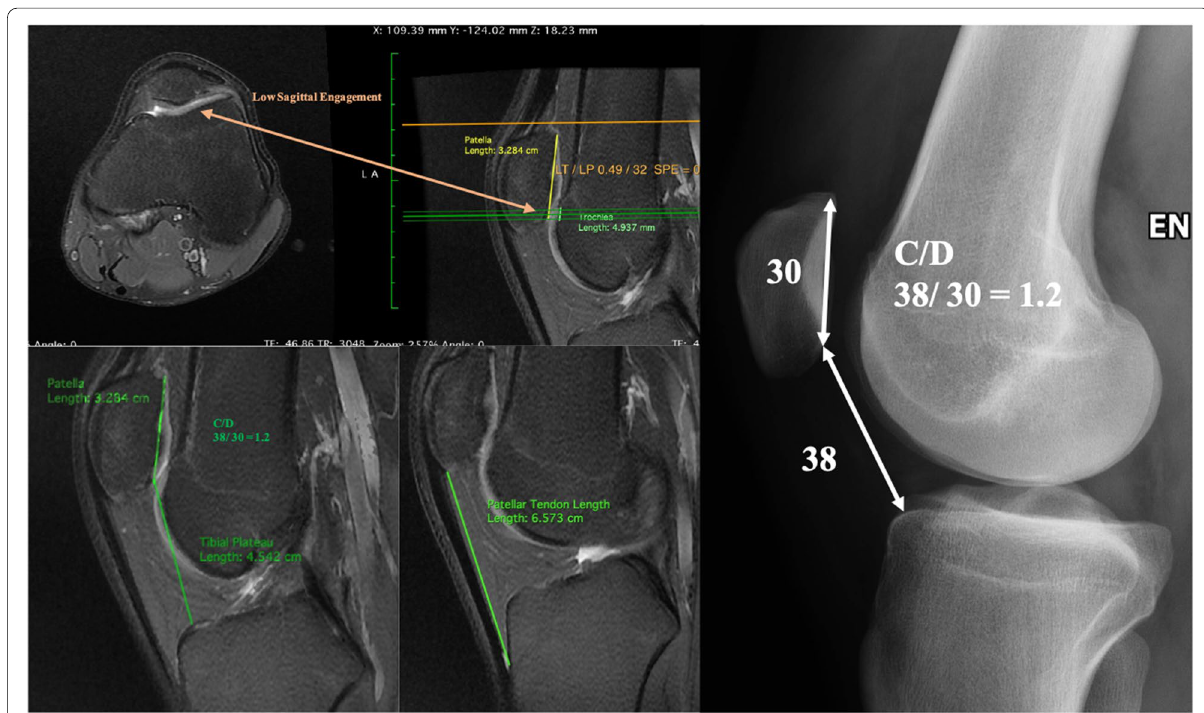
Fig. 4 Patella Alta quantification: X-ray with the Caton-Deschamps index, MRI with the Sagittal Patellar Engagement index, notice the patellar tendon